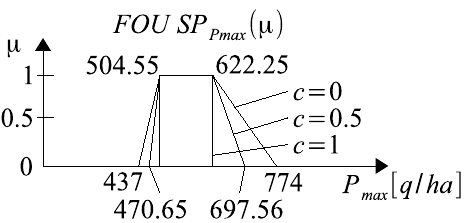
Figure 39. Footprint of uncertainty of the span function SP P max ( µ ) shown in 2D space, informing about possible values of the yield P max from the field at optimal nitrogen